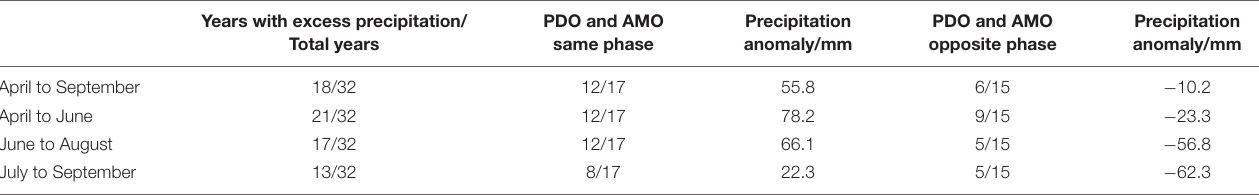
FIGURE 4 | Composition graph of the frequency of positive precipitation anomaly during Hunan flood seasons corresponding to different PDO and AMO phases from 1961 to 2019. TABLE 2 | Statistics of the precipitation in Hunan flood seasons in the next years of the El Niño events during 1910–2019.